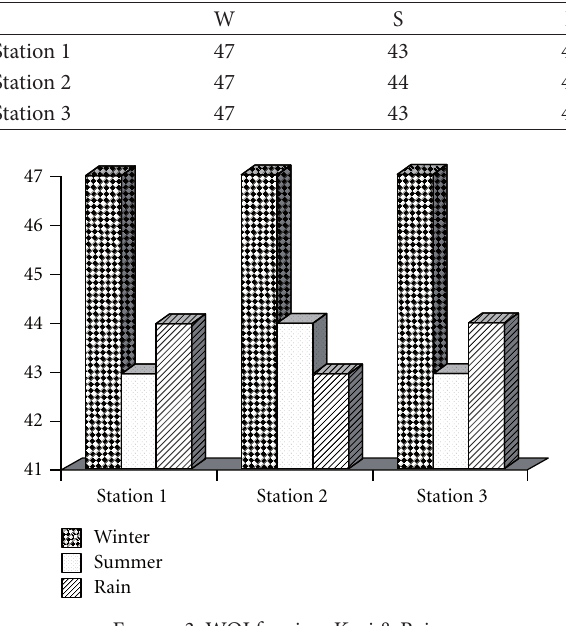
T 3: Water quality index of river Kosi and river Rajera at Rampur showing seasonal variations.